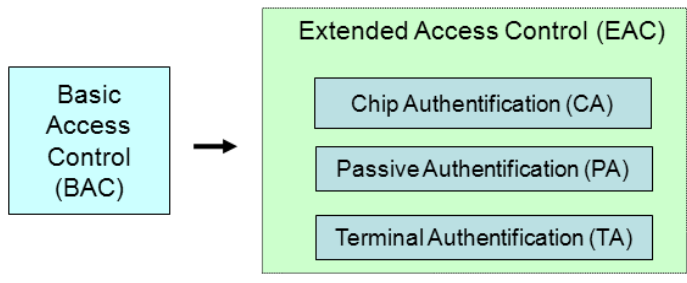
FIGURE 5. BAC and EAC for the new EU